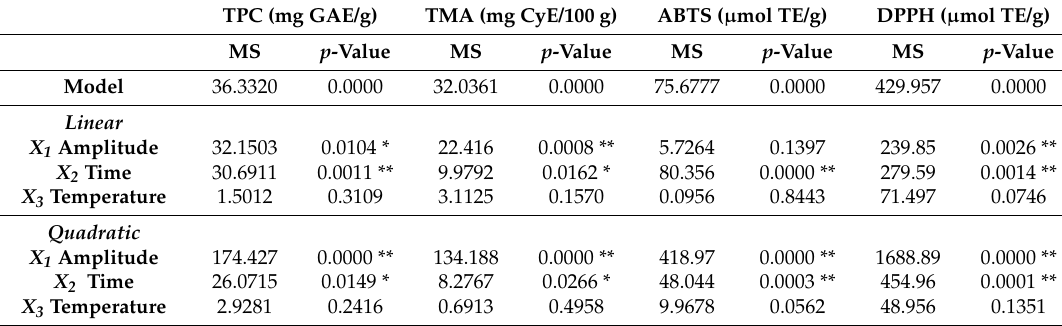
Table 2. The analysis of variance for the response surface model of the independent variables of UAE for the Brosimum alicastrum